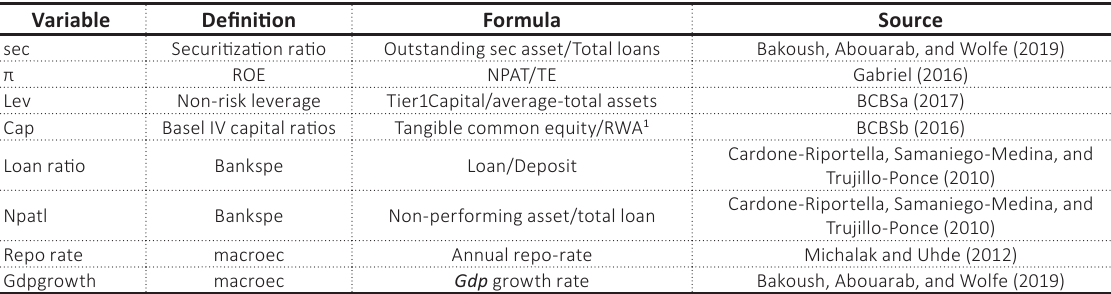
Table 1. Definition of model